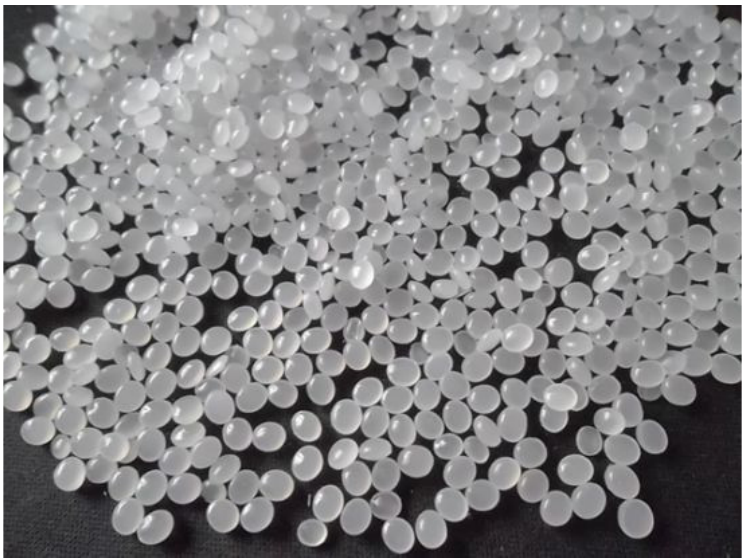
Figure 1. Plastics raw materials.